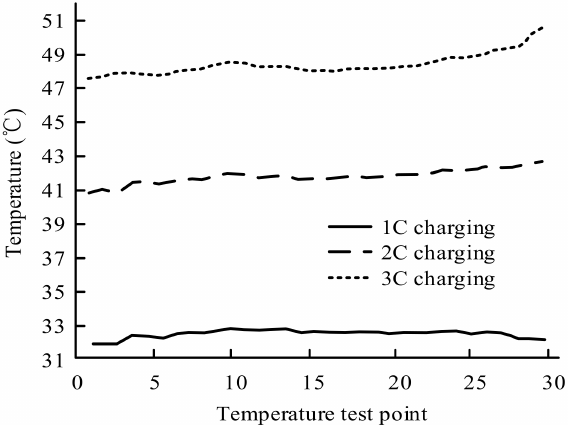
Figure 6. Simulated temperature distribution of lithium-ion battery pack.